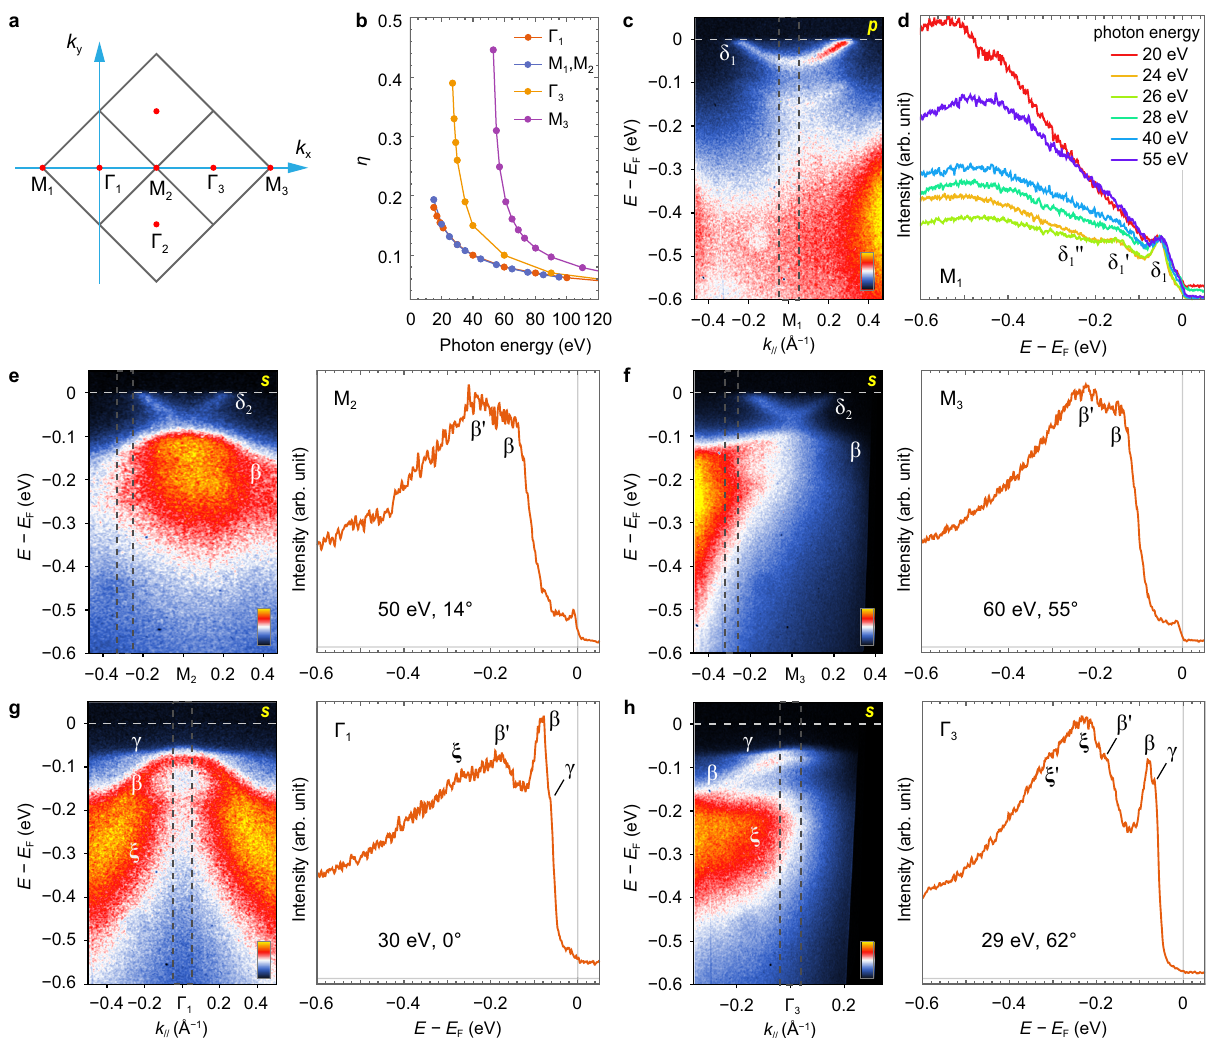
Fig. 5 Photon energy/emission angle-dependent ARPES results showing substantial variation of the background shape. a Extended reciprocal space and high-symmetry points of FeSe. The squares are BZ boundaries. b Calculated photon energy-dependent replica intensity at selected high-symmetry points, according to electron energy loss scenario. c ARPES map around M 1 point measured with p -polarized, 26-eV photons. d EDCs at M 1 taken with various photon energies, integrated over the momentum range indicated by the dashed rectangle in c . The curves are normalized by the principal peak maximum, and the background shows large variation with photon energy. e – h ARPES results at M 2 , M 3 , Γ 1 , and Γ 3 , respectively, measured with s- polarized photons. For each of e – h , the left panel is the intensity map, and the right is the integrated EDC, labeled with the photon energy and the emission angle of the electrons with respect to the sample normal. All measurements were taken with the analyzer slit along x direction.